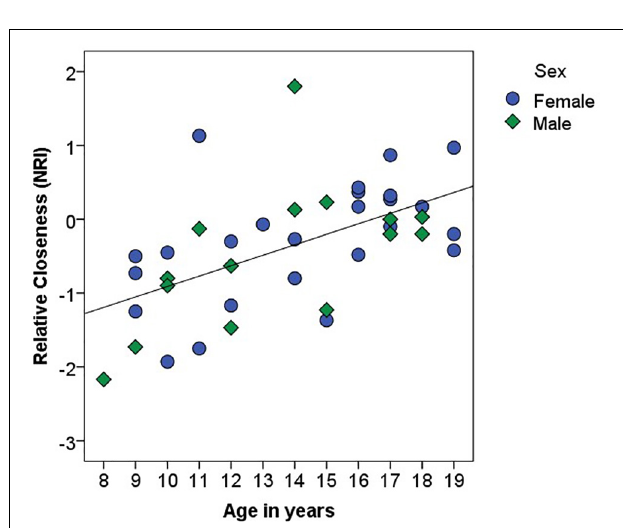
FIGURE 2 | Association between age (in years) and Relative Closeness on the Network of Relationships Inventory (NRI). Relative Closeness = closeness with peers – closeness with parents. Female participants are identified with blue circles; male participants are identified with green diamonds. The black line represents the linear relationship between the two variables ( R 2 =